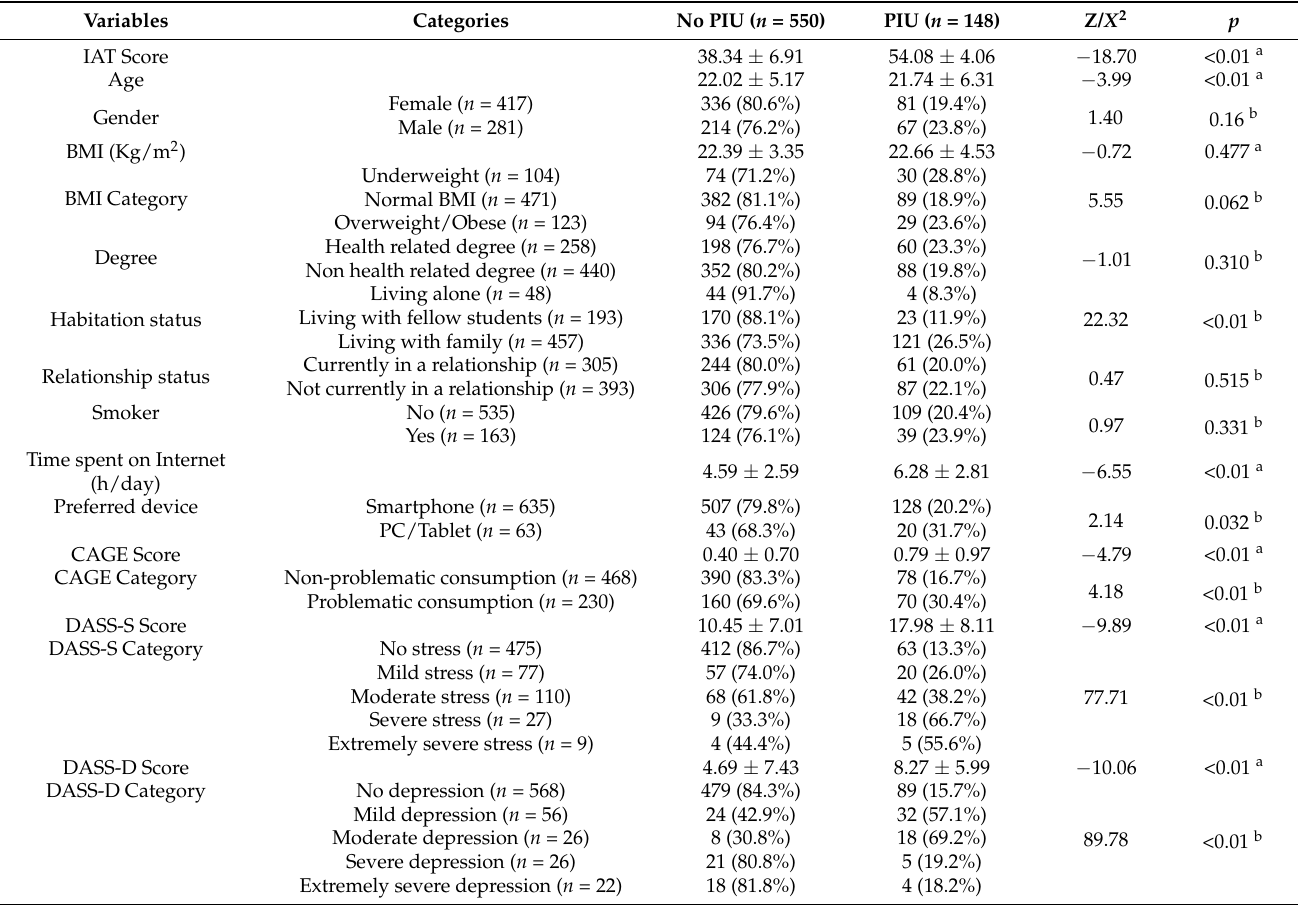
Table 2. Participant characteristics according to Internet use (number, % or mean ±